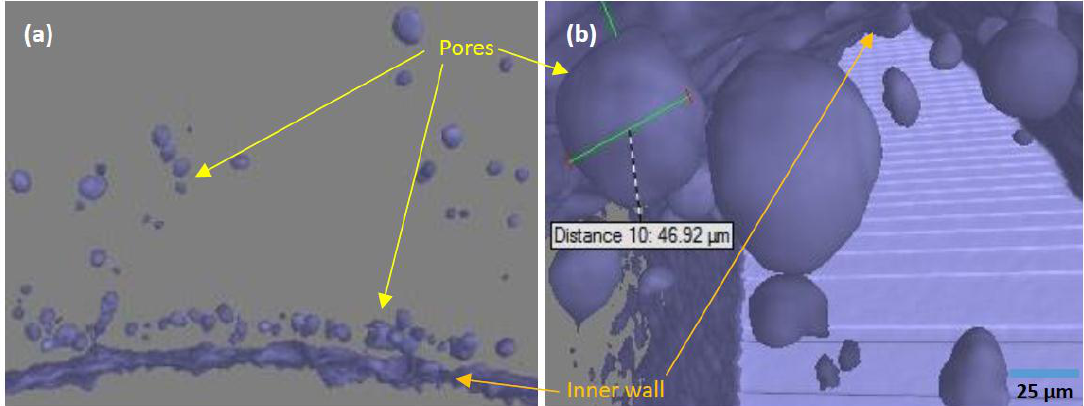
Figure 9. ( a ) Majority of the pores in the CT-scanned sample were observed close to the surface (inner wall) of the region in study; ( b ) Example of pore shape and size near the inner wall region.